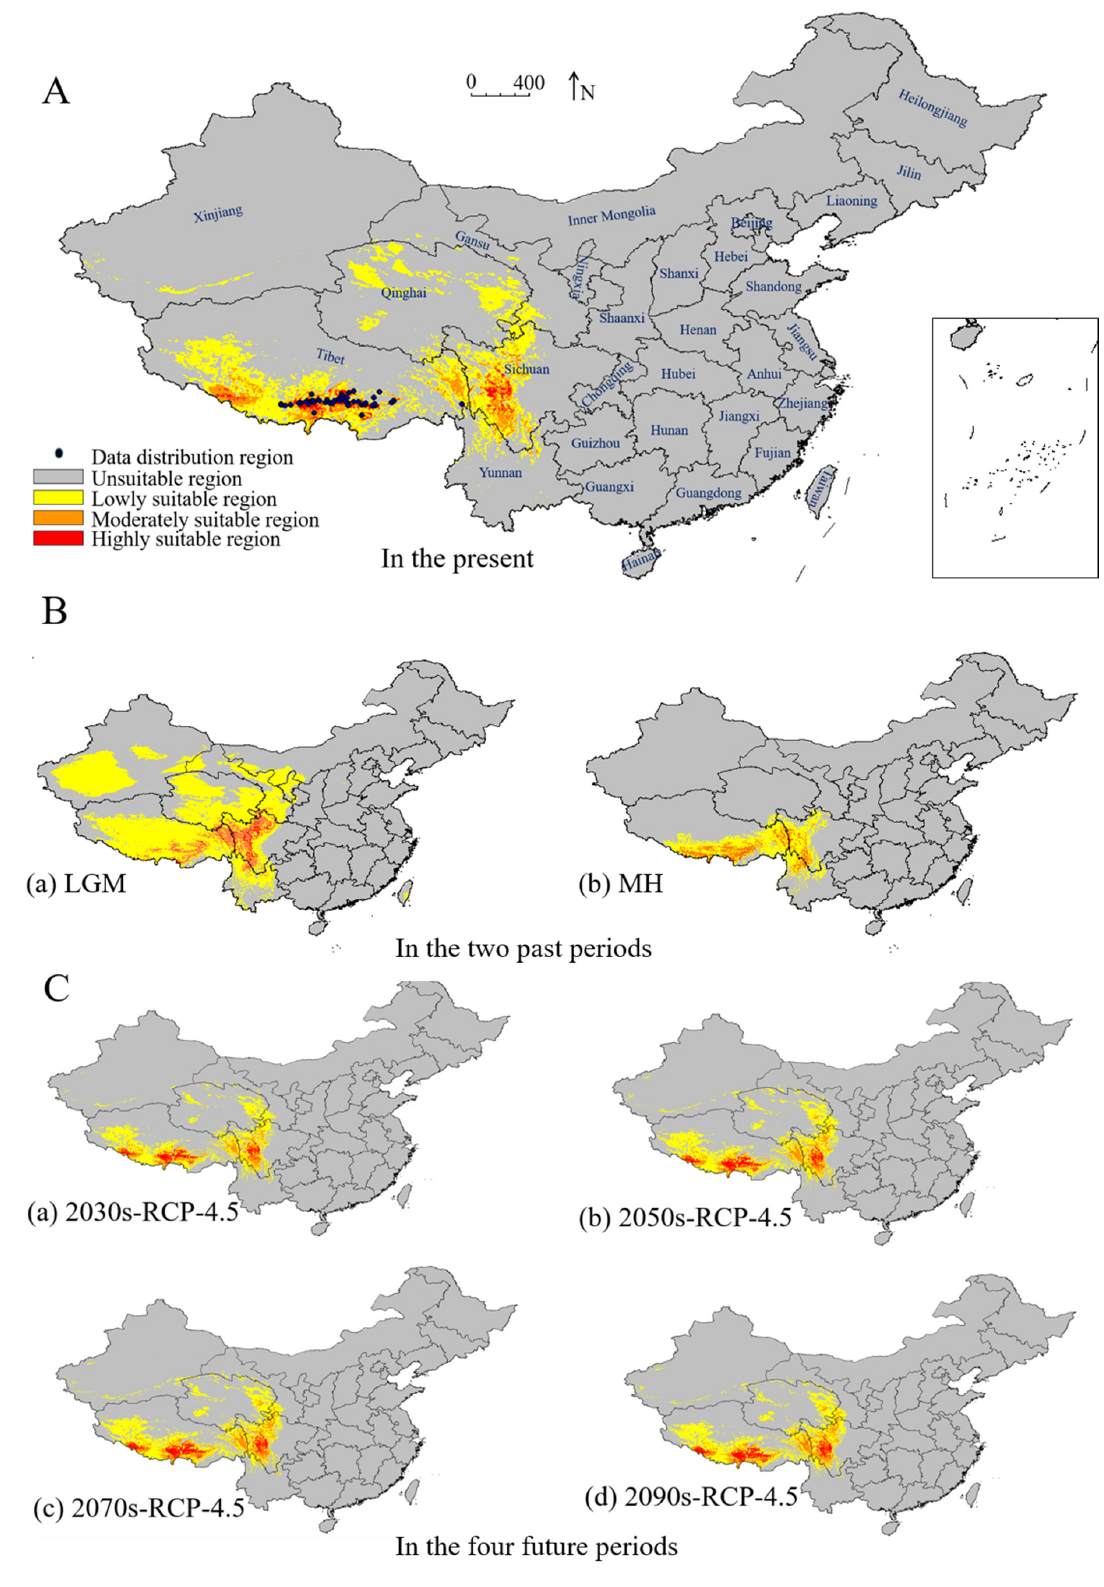
Figure 6. Suitable distribution area of S. moorcroftiana in China. ( A ) Suitable regional distribution and 60 data point distributions of S. moorcroftiana in the present period; ( B , C ) suitable regional distribution of S. moorcroftiana in the past two periods and four future periods by the RCP 4.5